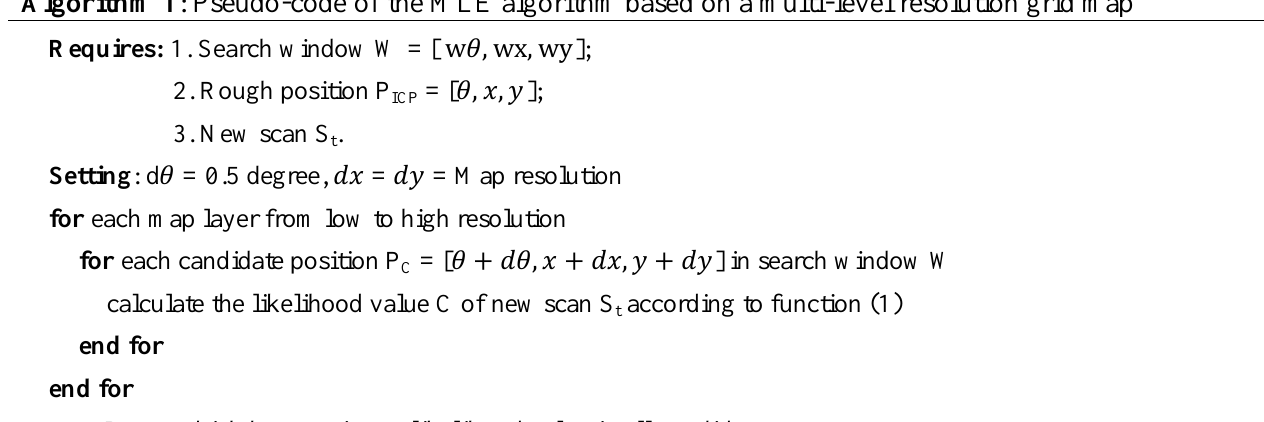
Algorithm 1 : Pseudo-code of the MLE algorithm based on a multi-level resolution grid